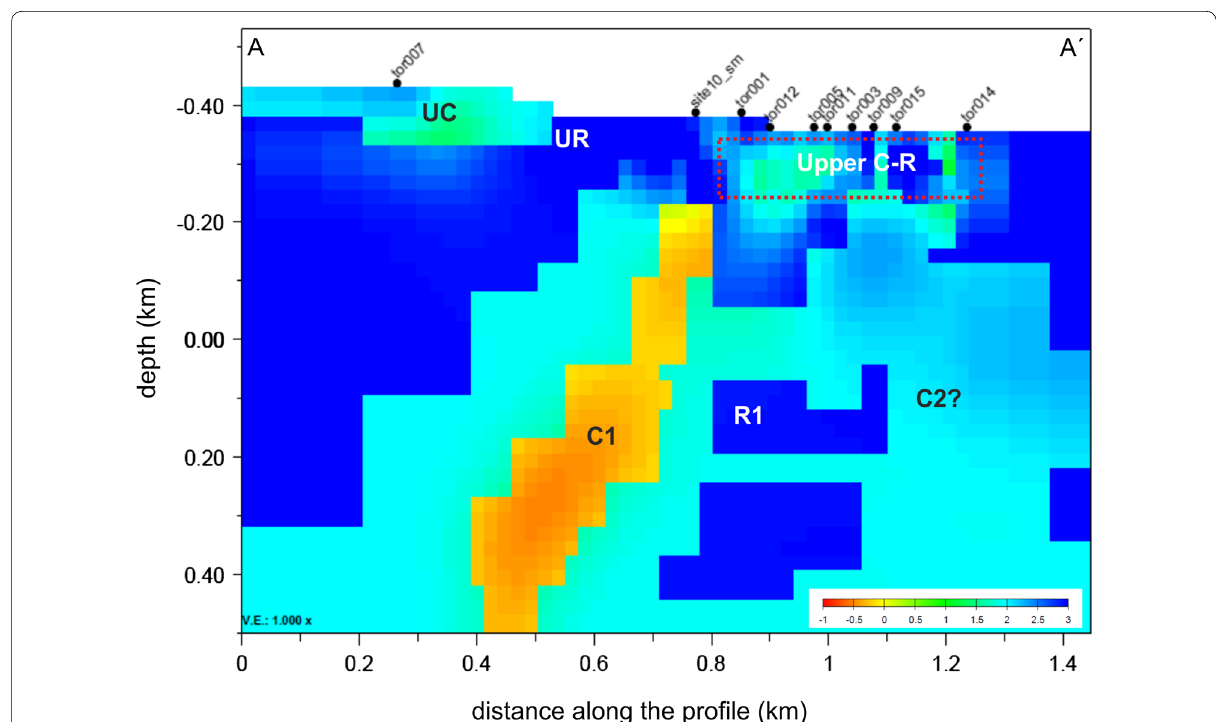
Fig. 10 Cross section of the model obtained from the inversion of qZ departing from the 2D model and extended to the full 3D mesh. Resistivity is indicated in decimal logarithmic scale